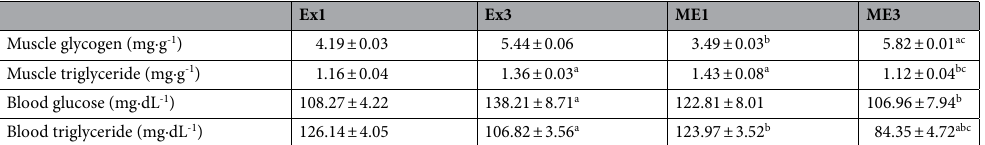
Table 2. Data on the muscular glycogen and triglyceride content, as well as the blood glucose and triglyceride concentrations, in the exercised groups (Ex1, Ex3, ME1, and ME3), those treated with the vehicle (Ex1 and Ex3) or melatonin (ME1 and ME3), and those euthanized 1 (Ex1 and ME1) or 3 (Ex3 and ME3) hours after t lim. Rats that exercised and were euthanized 1 h (Ex1) or 3 h after t lim (Ex3); rats that were treated with melatonin, exercised, and were euthanized 1 h (ME1) or 3 h after t lim (ME3). Values are expressed as the mean and standard error. a p < 0.05 with respect to Ex1; b p < 0.05 with respect to Ex3; c p < 0.05 with respect to ME1 for the same parameter. g: grams; mg: milligrams; dL: